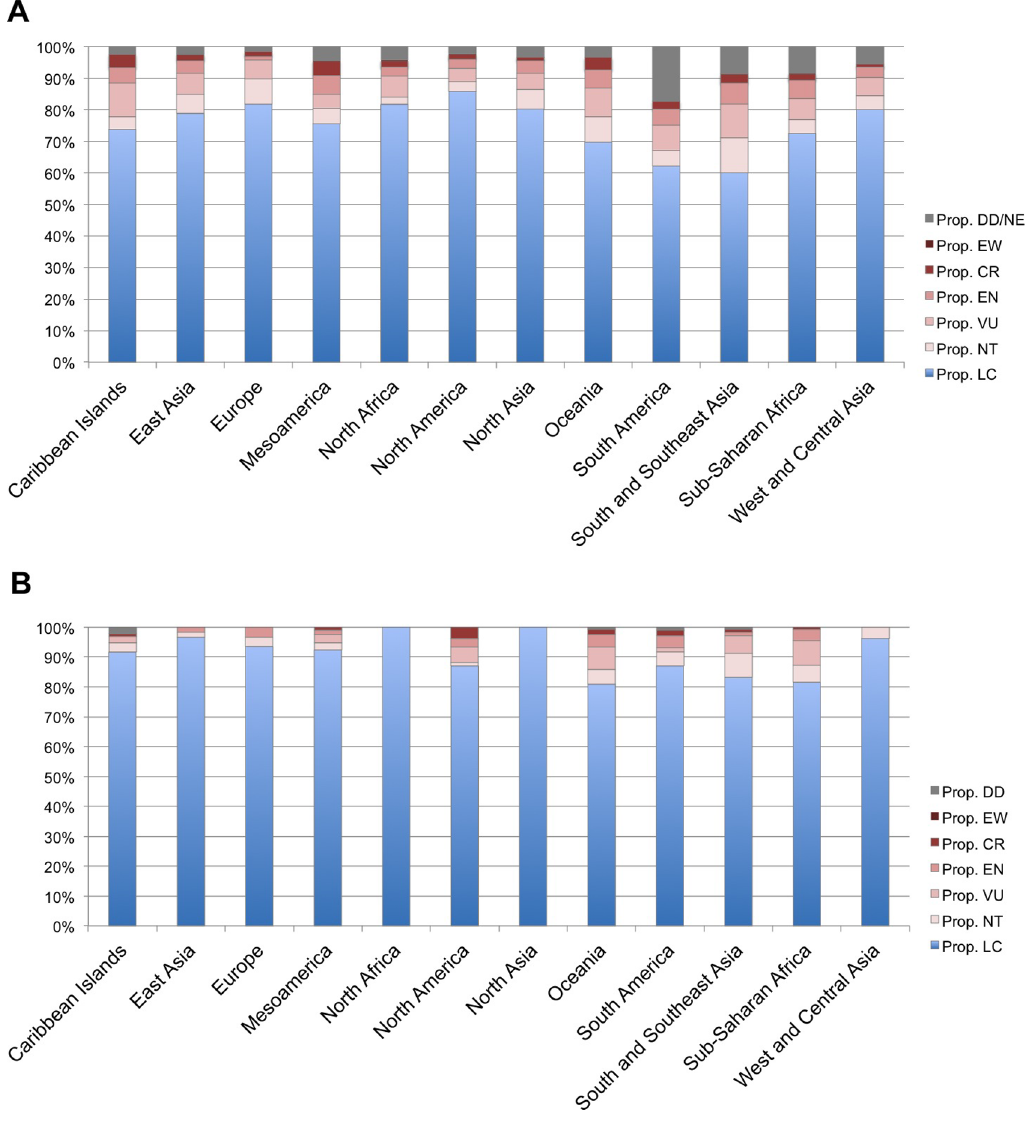
Figure 1. IUCN Red List threat levels by geographic region. a ) Threat levels for vertebrate seed dispersers. b ) Threat levels for vertebrate pollinators. Geographic regions are as provided in the IUCN Red List (www.iucnredlist.org). DD = Data Deficient. EW = Extinct in the Wild. CR = Critically Endangered. EN = Endangered. VU = Vulnerable. NT = Near Threatened. LC = Least Concern.